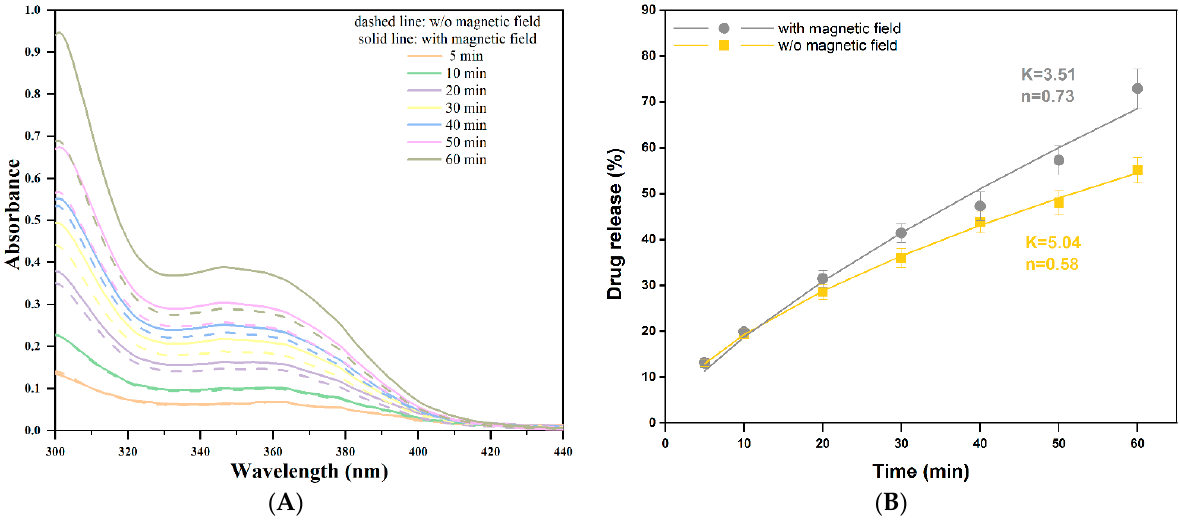
Figure 9. ( A ) Absorbance profile of 10G/Alg/FA/Fe 3 O 4 films at different time intervals without using a magnetic field (dashed line) and using a 0.5 T magnetic field as a trigger (solid line) and ( B ) folic acid release profile expressed as cumulative drug released. Data expressed as mean ± SD (n = 3). The points represent experimental data, and the lines represent fitting results.